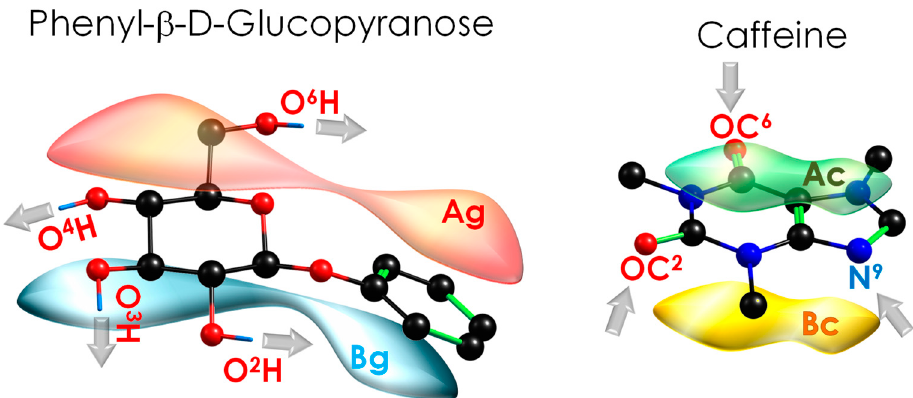
Figure 1. Phenyl- β -D-glucopyranoside (PhGlc) and caffeine (Caf) structures, with main binding sites highlighted. Note that the absence of symmetry in PhGlc results in several stacking orientations for the complex: the “A” surface of phenyl glucose (depicted in red, Ag) can interact with the “A” surface of caffeine (depicted in green, Ac) producing AgAc stacking structure. In the same way, other three combination are possible: AgBc, BgAc and BgBc, where the “B” surface of phenyl glucose (depicted in blue, Bg) and B surface of caffeine (depicted in yellow, Bc) combine with each other.